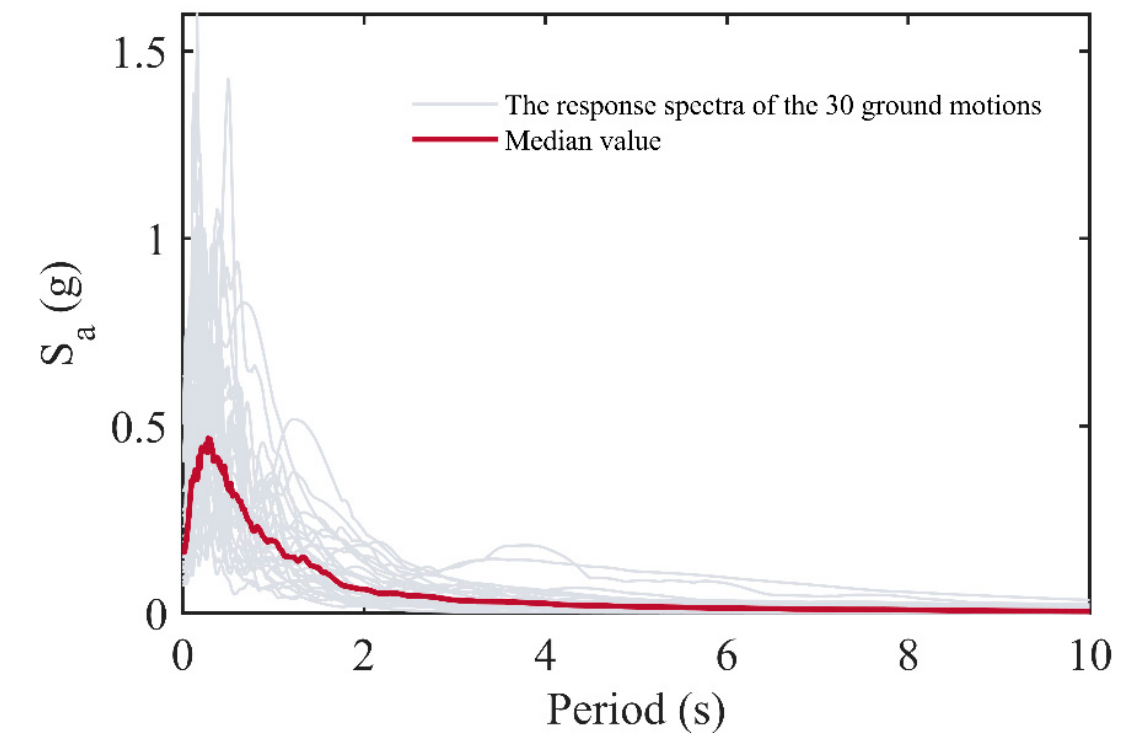
Figure 9. The response spectra of the 30 ground motions.